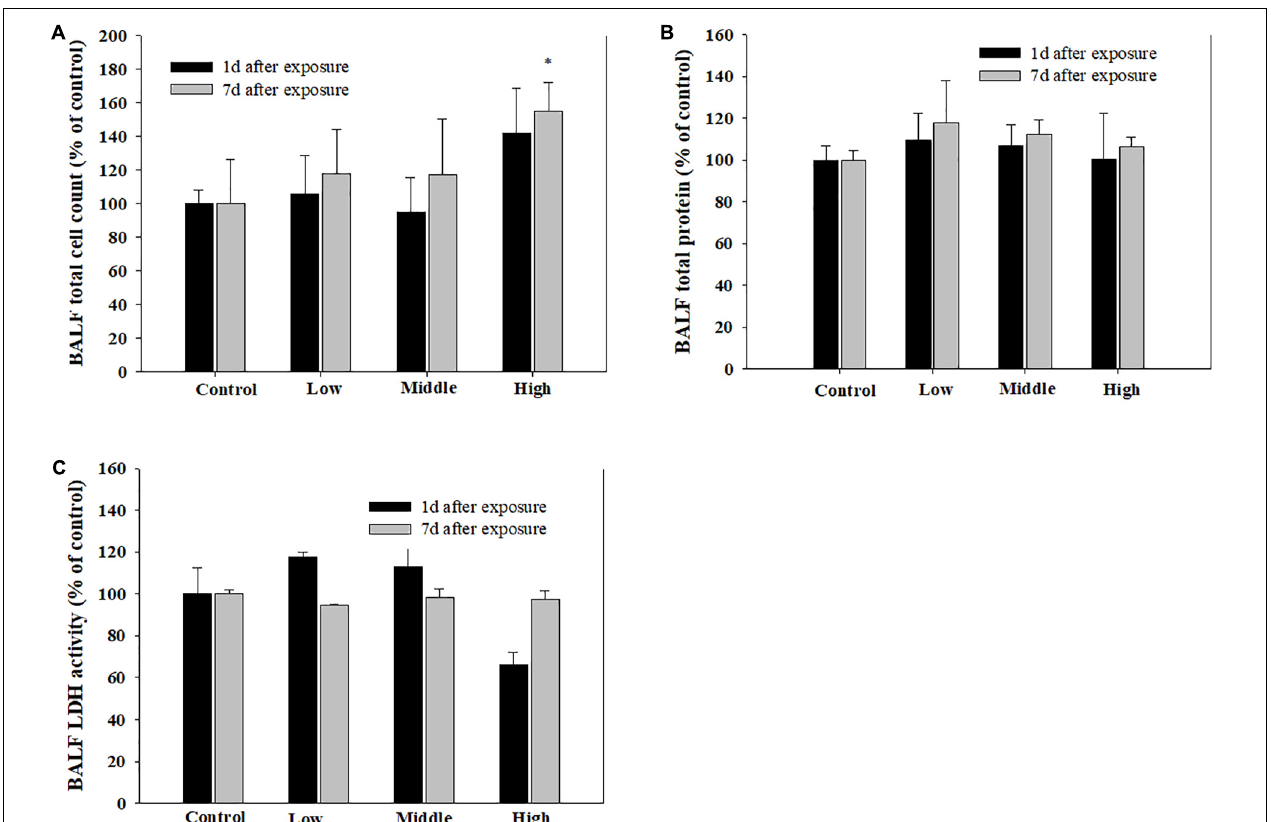
FIGURE 4 | The pulmonary toxicity induced by sub-acute inhalation of the SM in rats. (A) Total cell count in bronchoalveolar lavage fluid (BALF), (B) total protein (TP) content in BALF, and (C) lactate dehydrogenase (LDH) activity in BALF. Male rats inhaled aerosolic SM for 2 weeks. The values are reported as the mean ± SE.